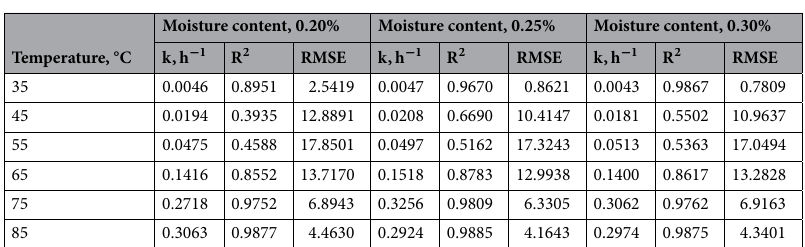
Table 6. Rate constant for CPO MC kinetics ( n = 1.0, i.e. first-order reaction).